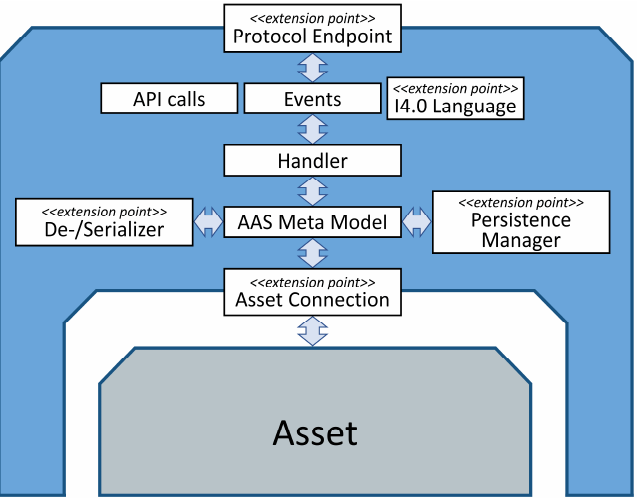
Figure 5. High-level architecture of the Fraunhofer AAS Tools for Digital Twin (FAST) library.